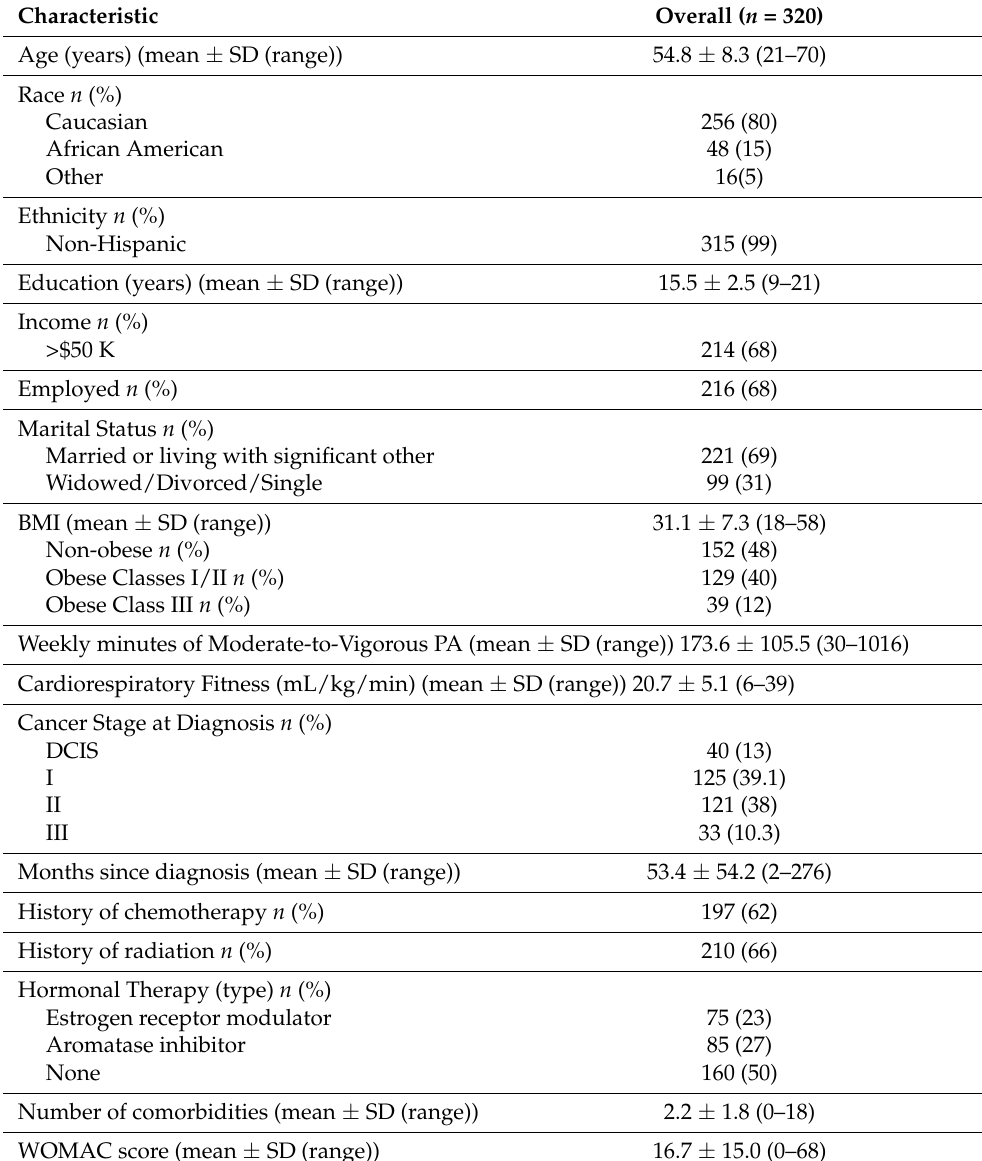
Table 1. Overall sample characterization ( n =